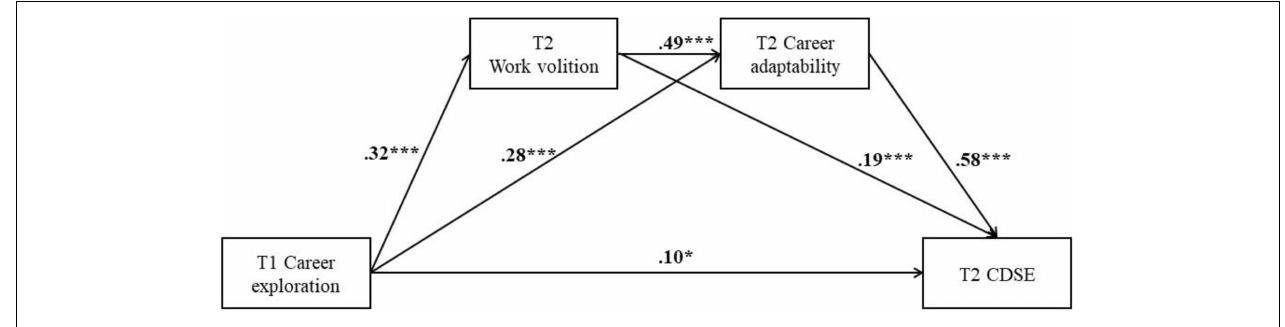
FIGURE 1 | Standardized parameter estimates of the effects of career exploration on CDSE mediated by work volition and career adaptability. * p < 0.05, *** p < 0.001.